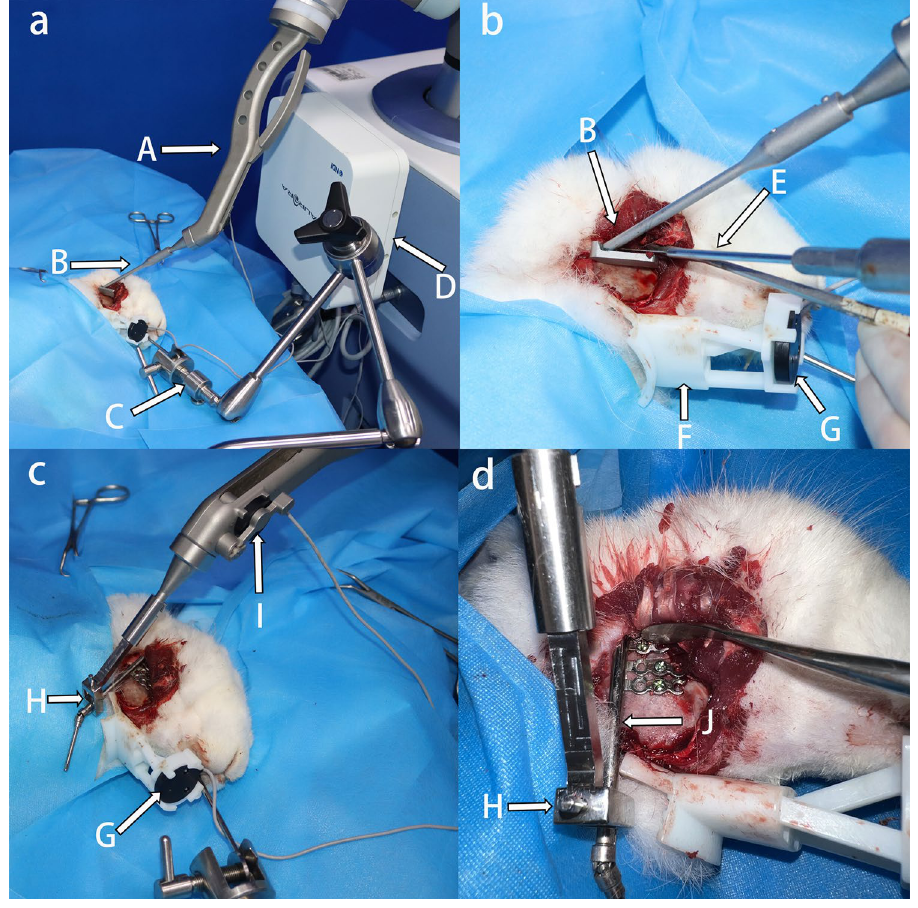
Figure 5. Robotic-assisted osteotomy and distractor positioning. ( a ) The template is at the initial target position. ( b ) Robotic-assisted osteotomy under electromagnetic navigation. The saw blade is against the template. The robot moves continuously from the initial position to the second position along the osteotomy line, with the saw blade following it forward. ( c ) The template has been replaced with the clamp, which holds the distractor in motion to the expected position. ( d ) Distractor implantation is completed after drilling and tightening the screws. (A) robotic arm sub-end, (B) template, (C) fixator, (D) electromagnetic generator, (E) bone saw, (F) registration complex, (G) electromagnetic sensor connected to the mandible, (H) clamp, (I) electromagnetic sensor connected to the robotic arm, (J) distractor.